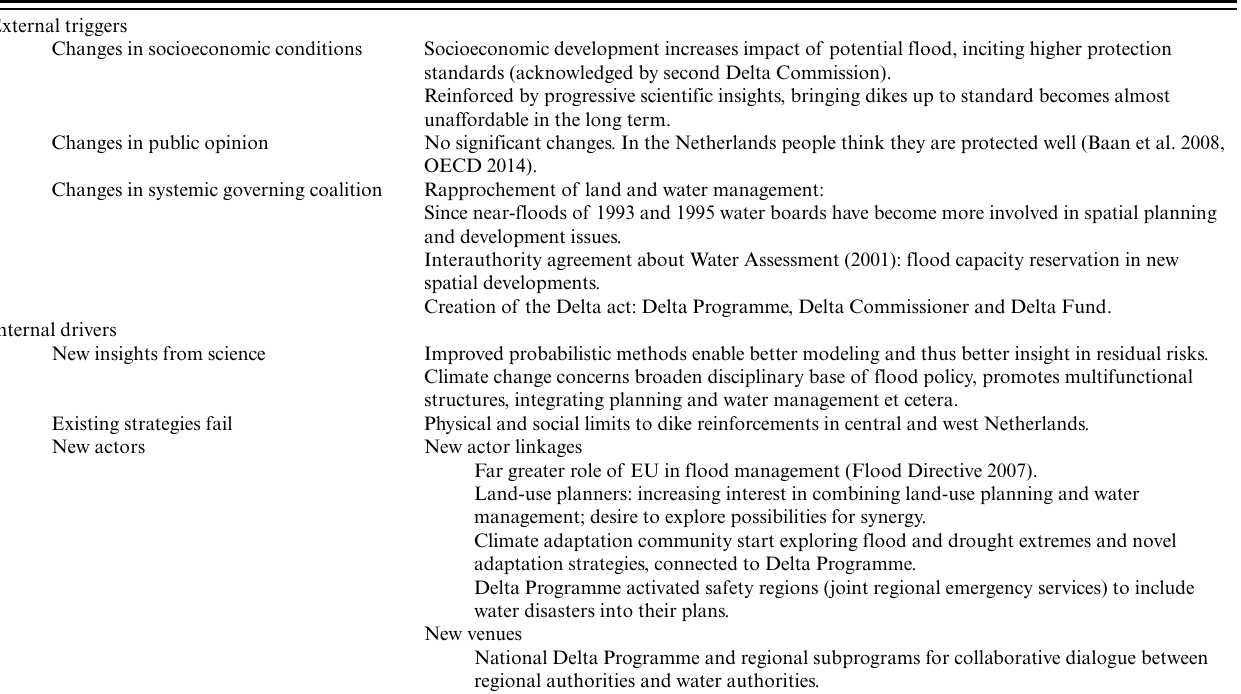
Table 3 . Triggers for policy learning in Dutch flood